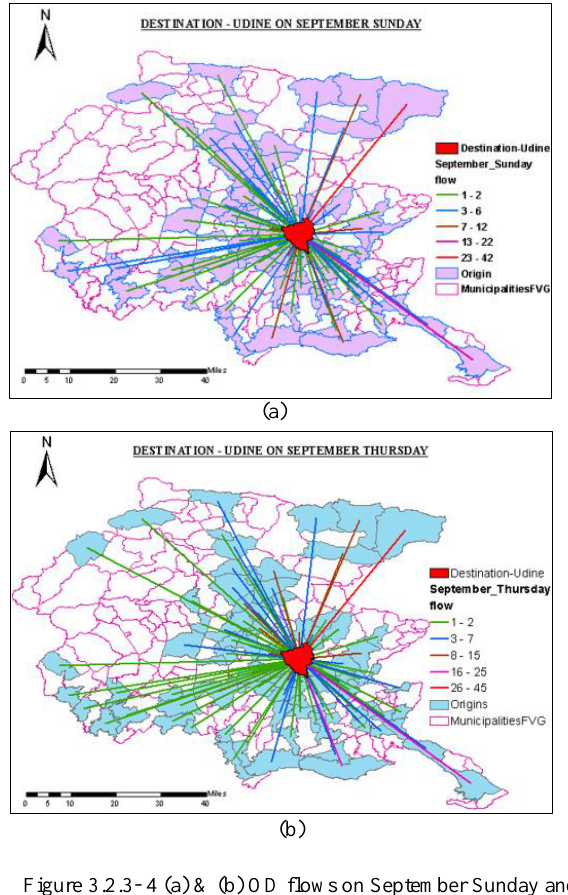
Figure 3.2.3- 4 (a) & (b) OD flows on September Sunday and Thursday